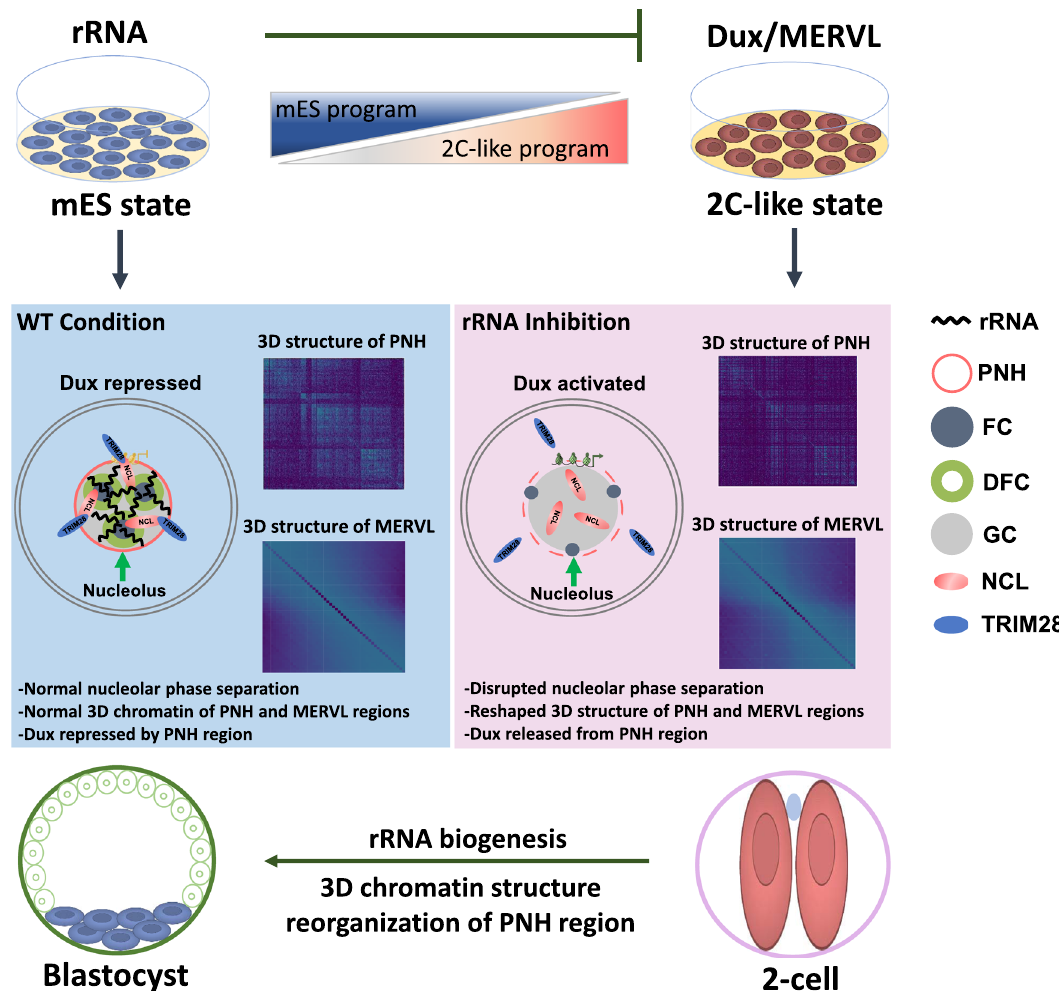
Fig. 10 A mechanistic model for the role of rRNA biogenesis in regulating mouse 2C-like state. In the unperturbed mES cells, nucleolar integrity mediated by rRNA biogenesis maintains the normal liquid-liquid phase separation (LLPS) of nucleolus and the formation of peri-nucleolar heterochromatin (PNH) containing Dux , and this normal nucleolar LLPS facilitates NCL/TRIM28 complex occupancy on the Dux locus and repression of Dux expression. In contrast, in the rRNA biogenesis-inhibited mES cells, the natural liquid-like phase of nucleolus is disrupted, causing dissociation of the NCL/TRIM28 complex from PNH and changes of epigenetic state and 3D structure of PNH, which eventually leads to Dux released from PNH, activation of 2C-like program and transition of mES cells to 2C-like